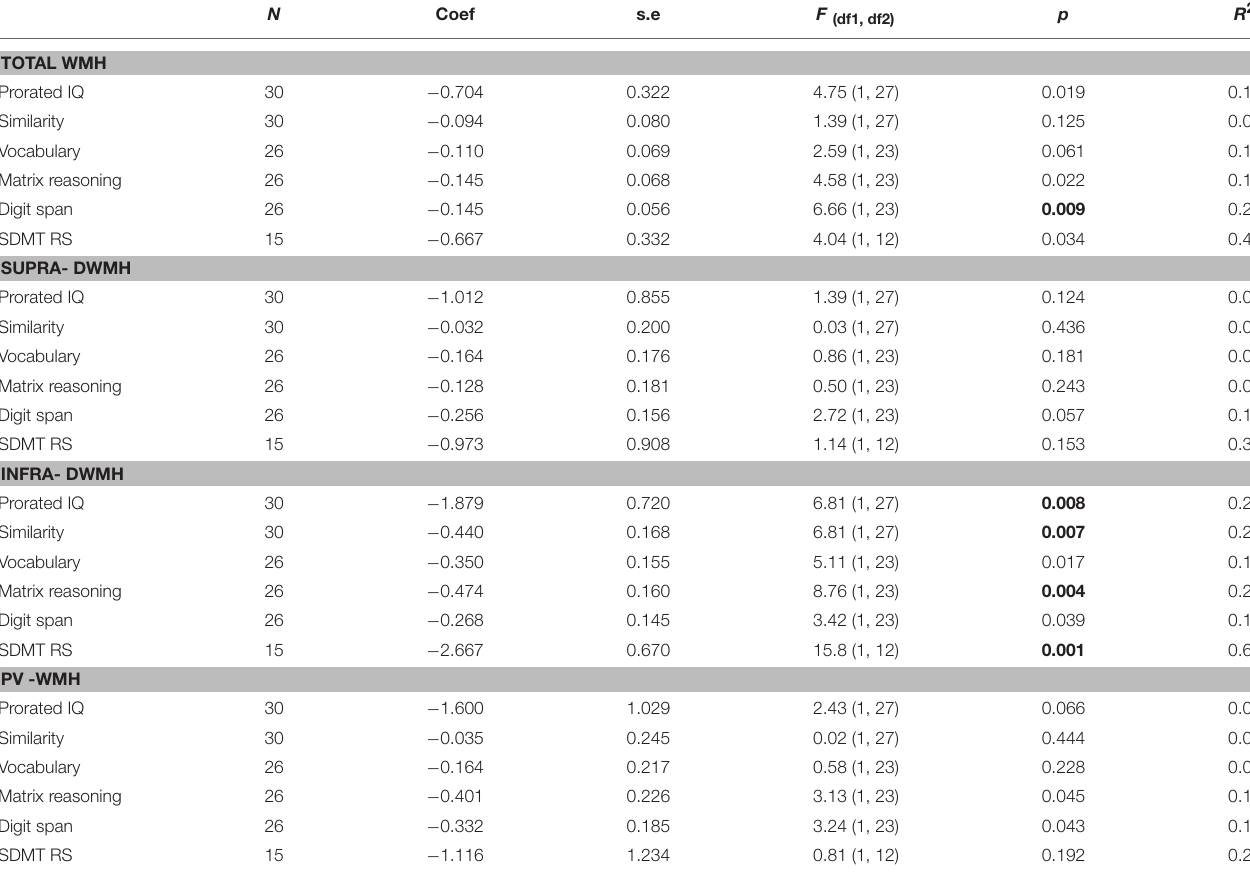
TABLE 2B | Relationship between each cognitive score (outcome) and each wmhs score (predictor), adjusted for age, in the total sample of PM carriers.